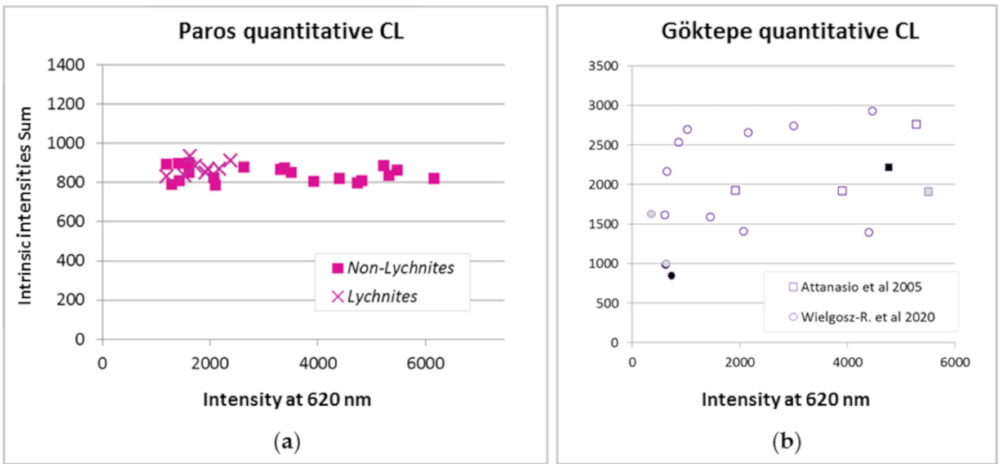
Figure 7. ( a ) Quantitative CL diagram for Parian marbles, Paros − 1 (lychnites) and non-lychnites (Paros 2–3) according to their location [30]; ( b ) Quantitative CL diagram for Göktepe marbles with an indication of providers. Three samples of black Göktepe (in black symbols) and three grey marbles (in grey symbols) were